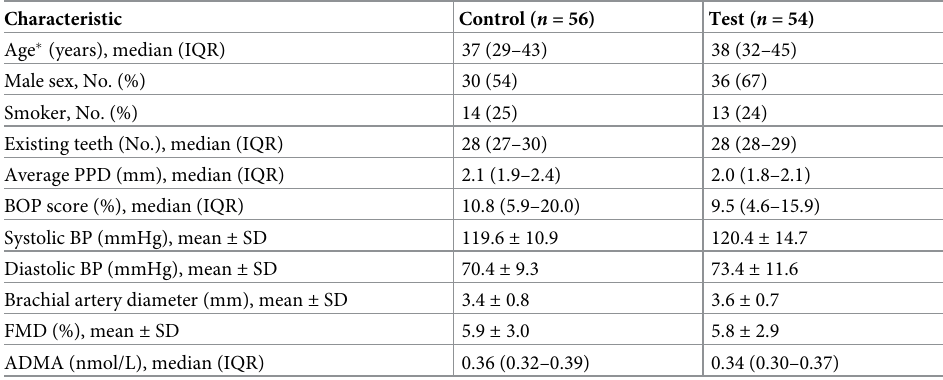
Table 1. Baseline characteristics of the patients.